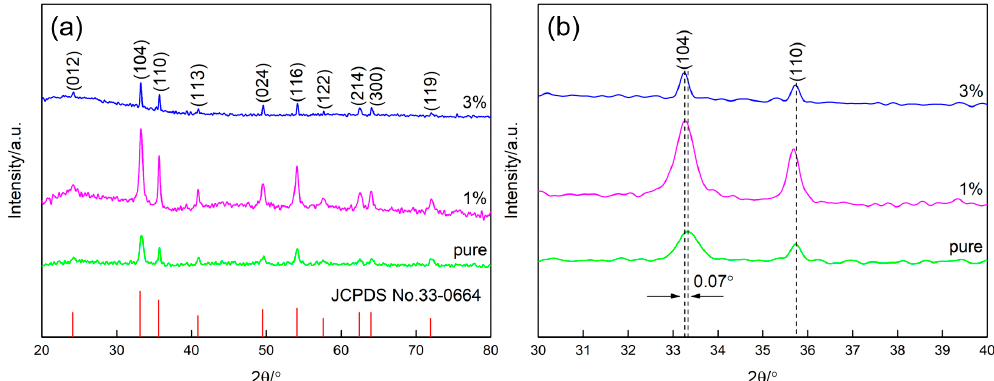
Figure 3. XRD patterns of pure α -Fe 2 O 3 , 1% Zn-doped α -Fe 2 O 3 , and 3% Zn-doped α -Fe 2 O 3 in the 2 θ range of ( a ) 20–80° and ( b ) 30–40°.